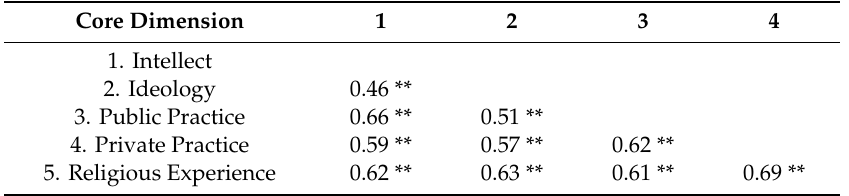
Table 7. Correlation Matrix of CRSi-14